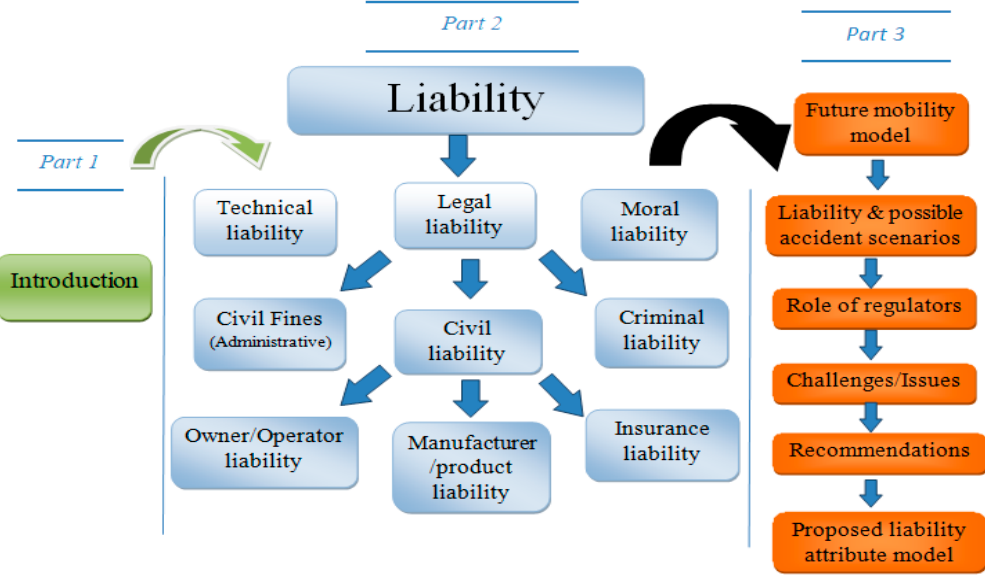
Figure 2. Overall structure of the research.